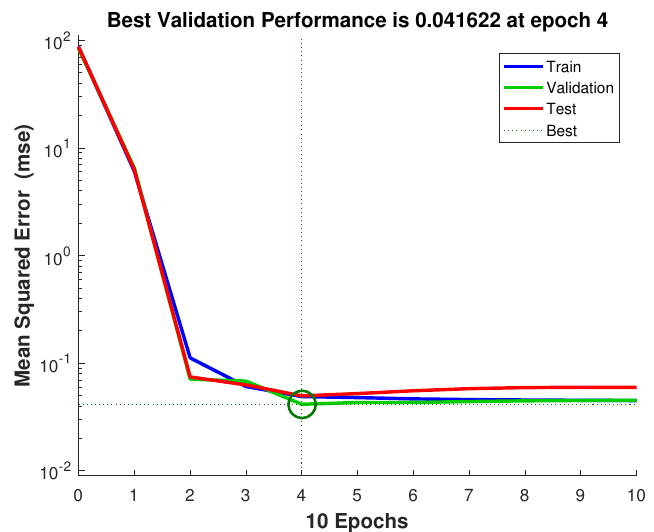
Figure 9. Training process-second test